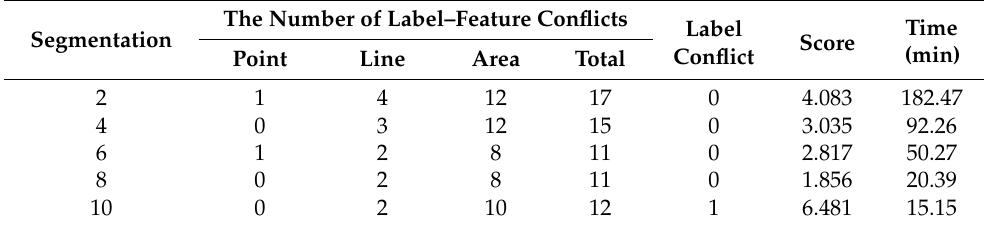
Table 2. Applying different numbers of segmentations on the first dataset.